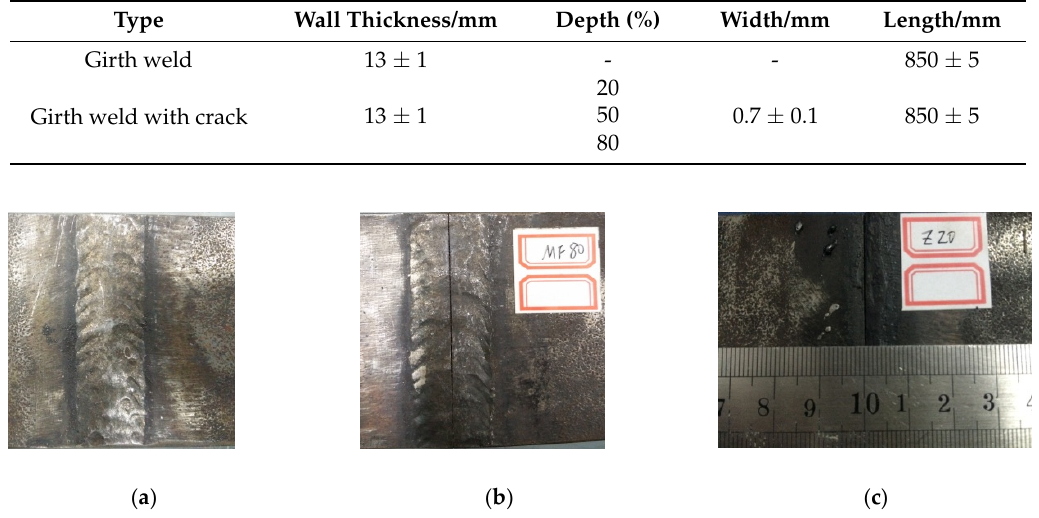
Figure 4. Physical photographs of the test specimens. ( a ) Photograph of the girth weld. ( b ) Photograph of the girth weld with crack. ( c ) Size of the crack.